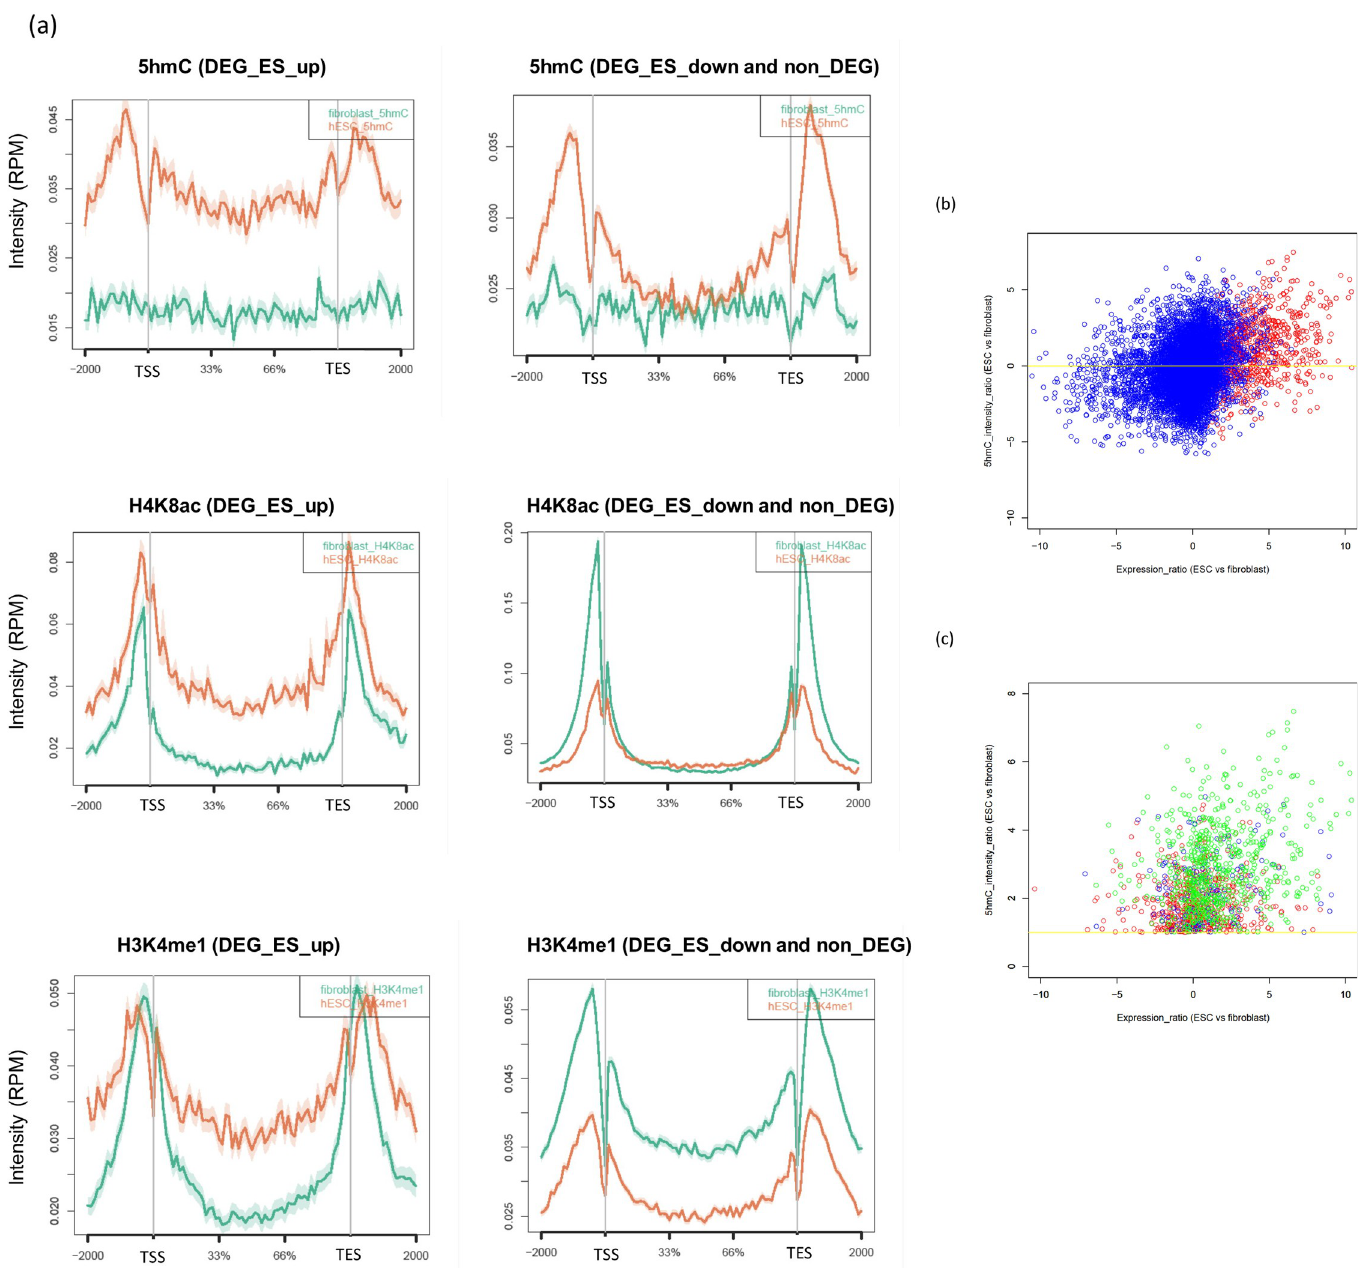
Fig 2. Distribution of reads for 5hmC, H4K8ac, and H3K4me1 around gene regions. (a) The difference of average distributions of each factor in the gene region. Orange lines are on hESC and green lines are on fibroblast. The y-axis indicates intensities (normalised read count), and the figures show the average distributions of reads on whole genes. (b) The scatter plots of genes between their expression ratio and the 5hmC intensity ratio. X-axis indicates gene expression ratio (ESC / fibroblast) in log2 scale. Y-axis indicates 5hmC intensity ratio (ESC / fibroblast) in log2 scale. The red circles show DEG_ES_up genes, while the blue circles show DEG_ES_down and non_DEG genes. (c) The scatter plot of genes between their expression ratio and the 5hmC intensity ratio with different number of marks. X-axis indicates gene expression ratio (ESC / fibroblast) in log2 scale. Y-axis indicates 5hmC intensity ratio (ESC / fibroblast) in log2 scale. Red circles represent genes which show only 5hmC enrichment, blue circles represent genes which show 5hmC and H3K4me1 enrichment only, and green circles represent genes which show the trivalent enrichment. All genes show 5hmC enrichment in ESCs (fold change over 1, as shown by yellow